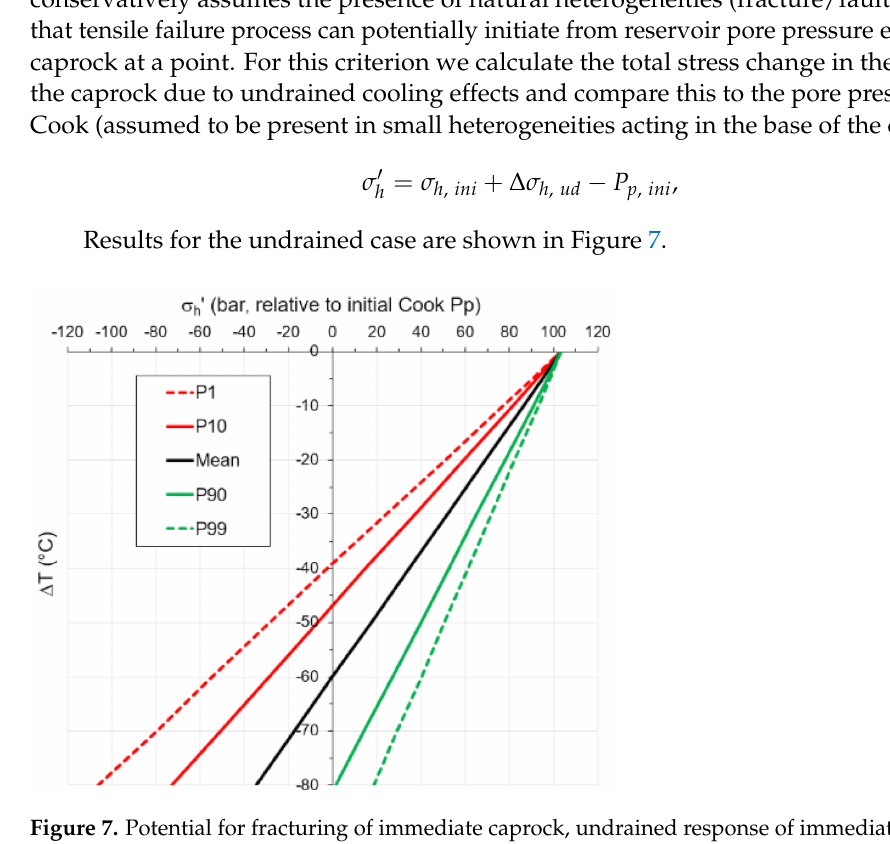
Figure 7. Potential for fracturing of immediate caprock, undrained response of immediate caprock to cooling in relation to virgin pore pressure at top